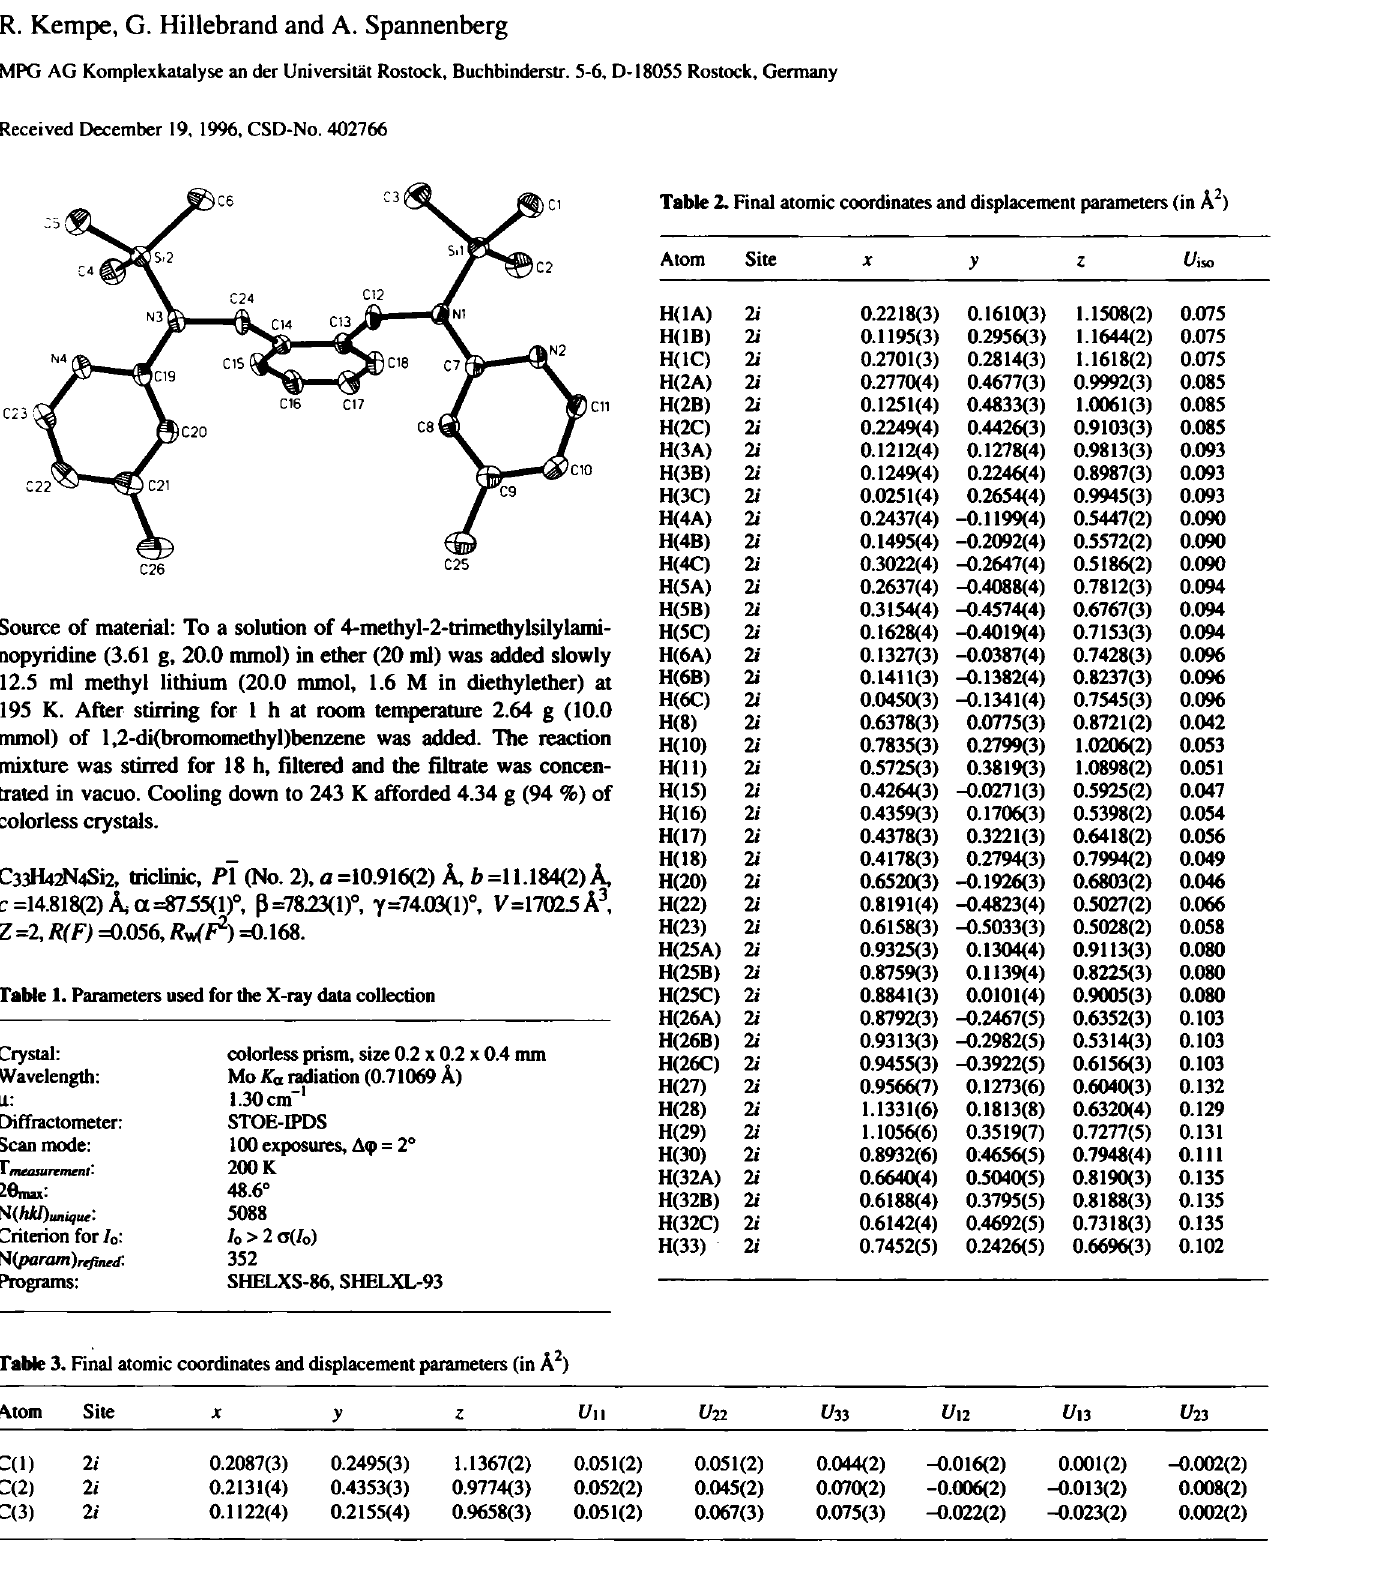
Table 3. Final atomic coordinates and displacement parameters (in Â 2